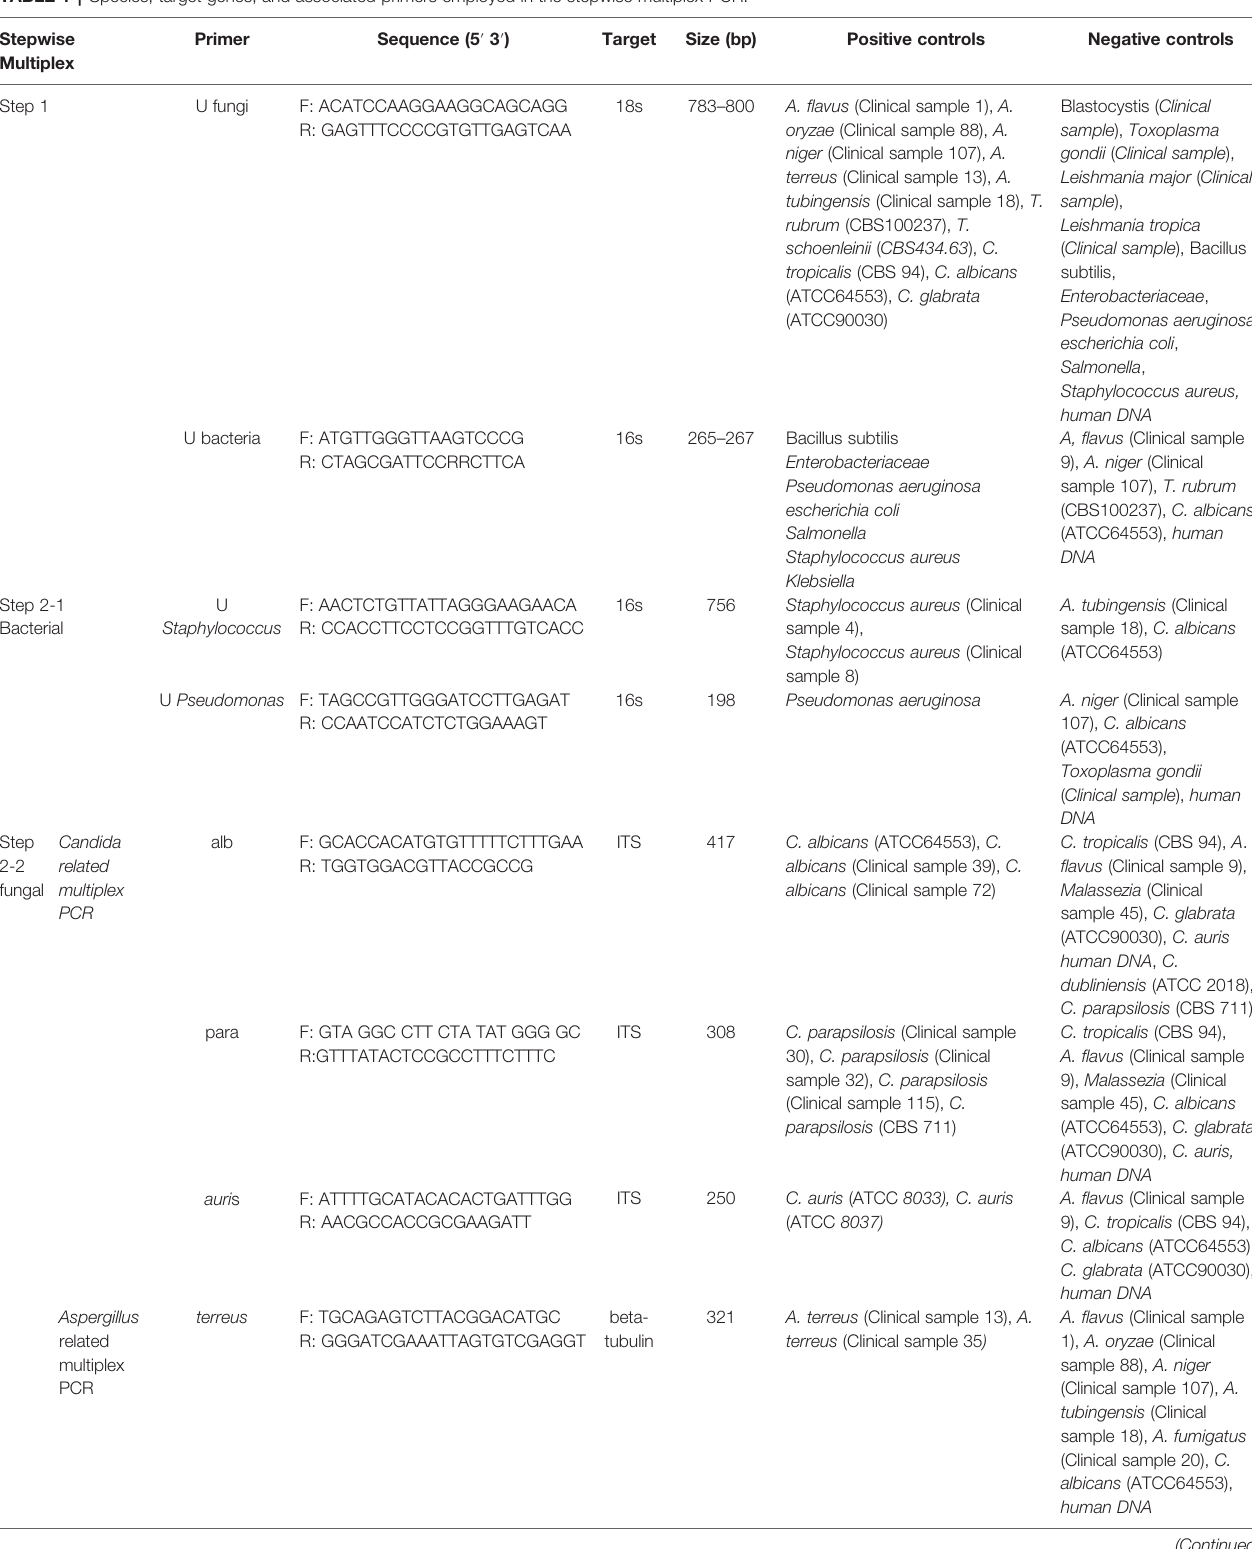
TABLE 1 | Species, target genes, and associated primers employed in the stepwise multiplex